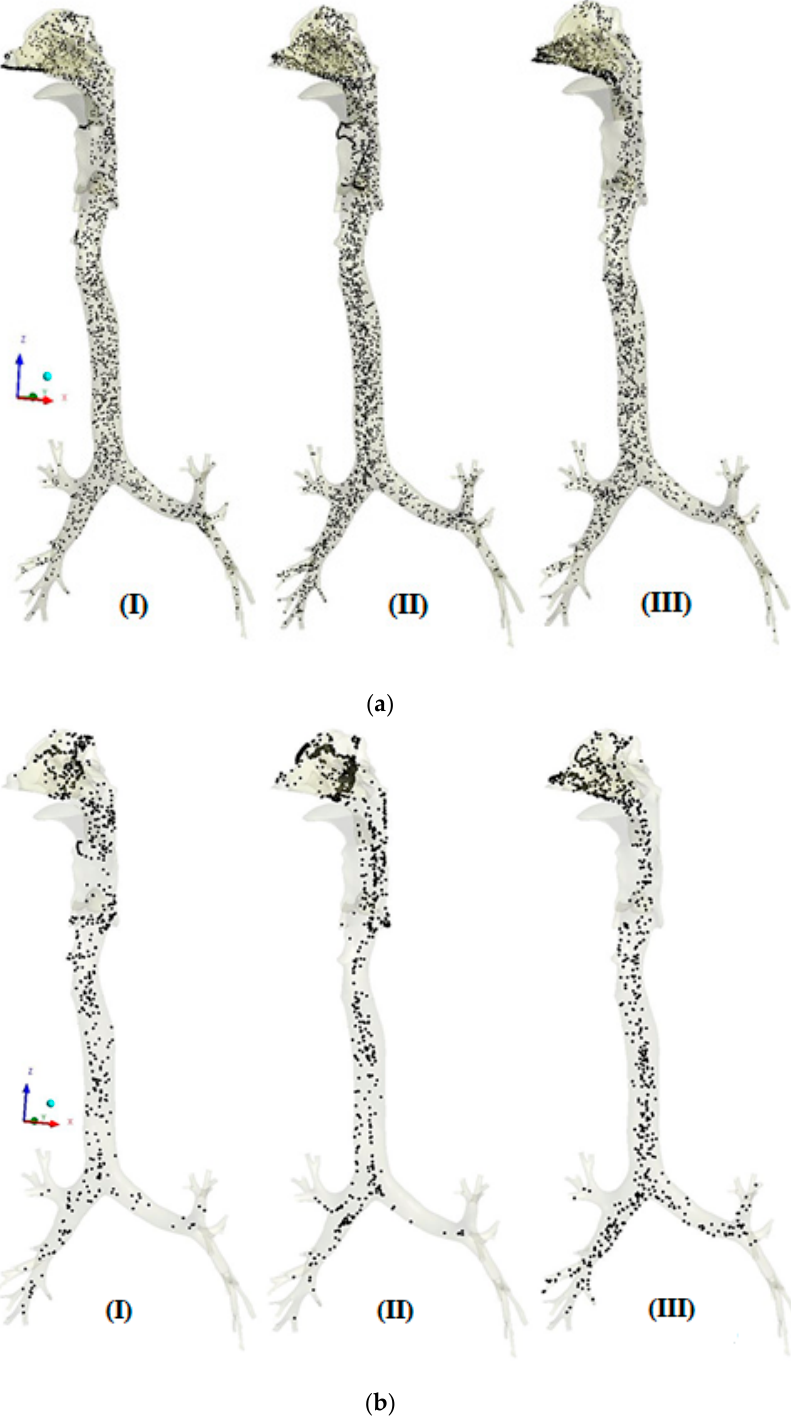
Figure 5. ( a ) Transport pattern of PM 2.5 during moderate inspiration. ( b ) Transport pat- during moderate tern of PM 10 during moderate inspiration.